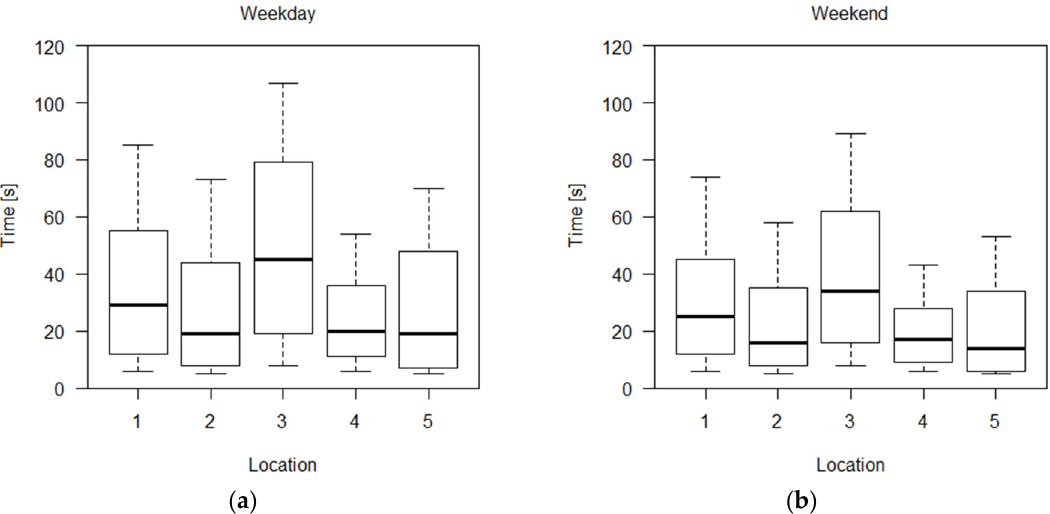
Figure 6. Boxplot for the transit time observed at each location in the analyzed period ( a ) Weekday, ( b ) Weekend (box: 75th and 25th percentiles; whiskers: 10th and 90th percentiles; bold line: median). Figure generated using R [42].